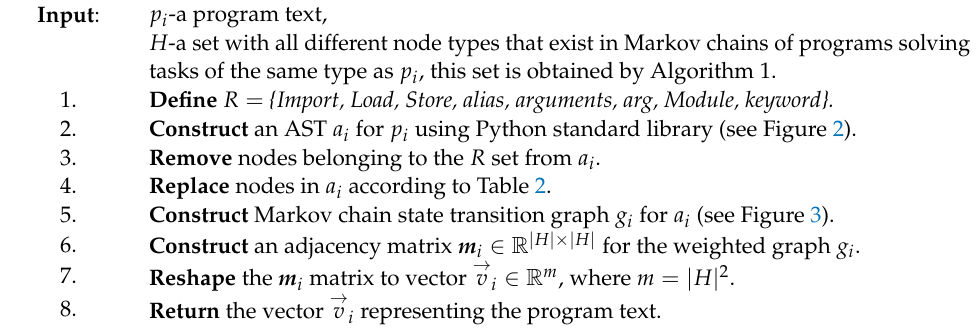
Algorithm 2 Vectorization of a single program text p i based on Markov